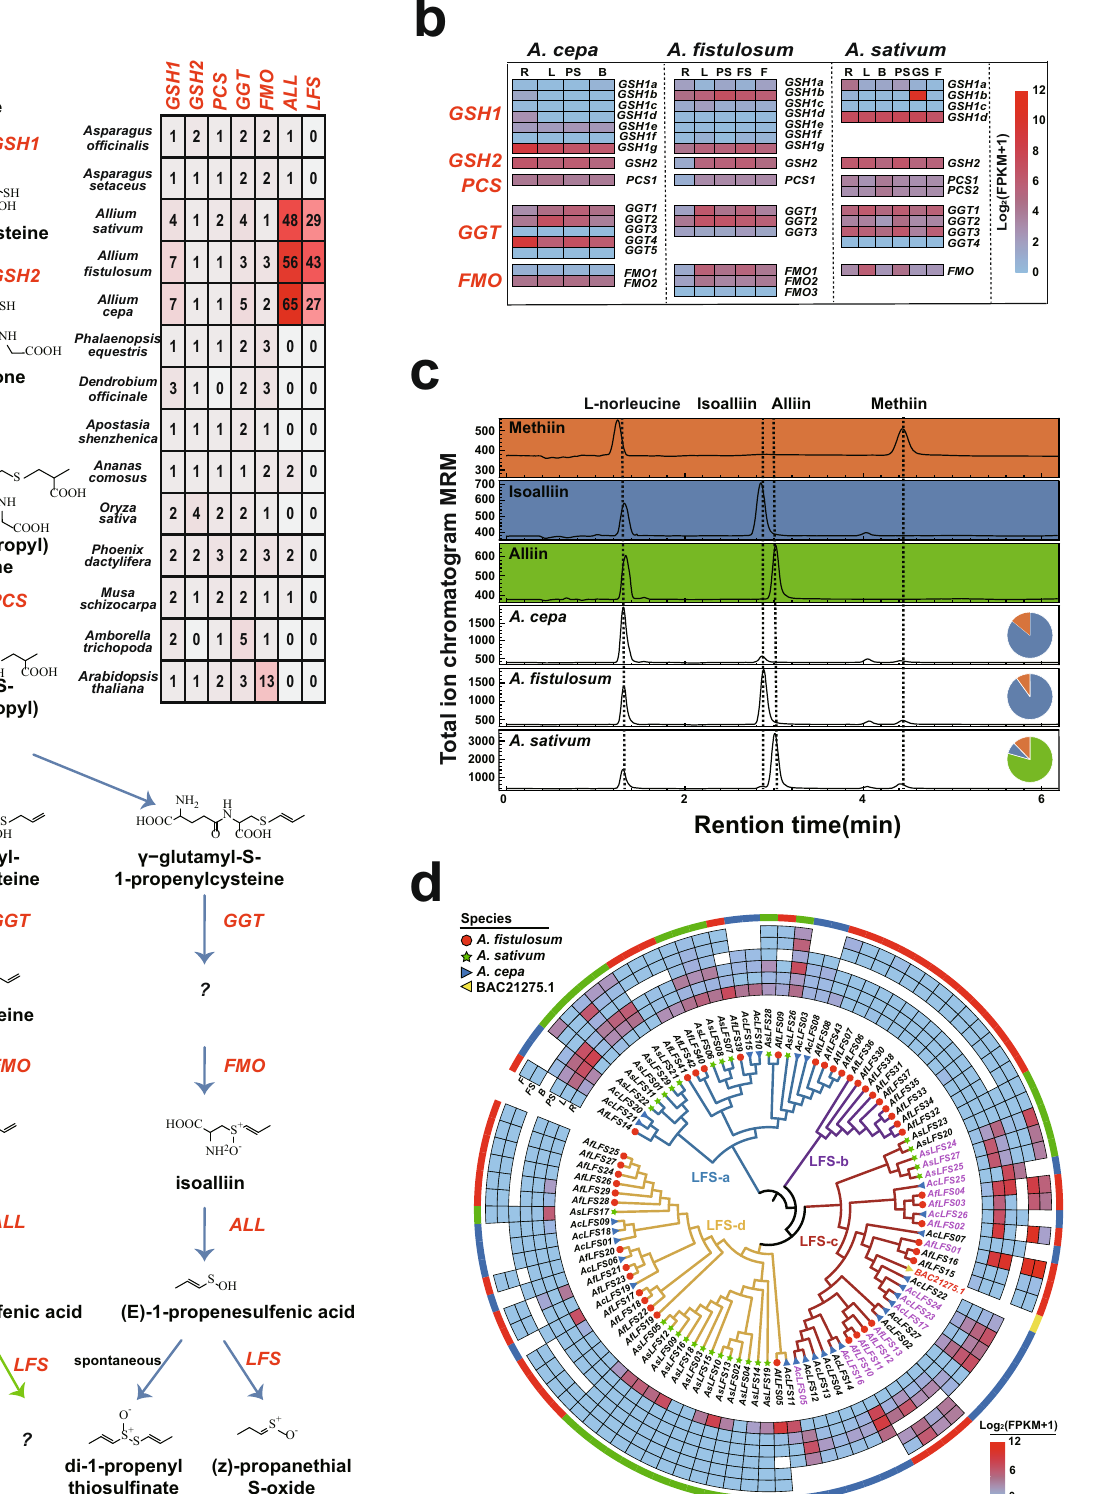
Fig. 4 | Massive duplication and differentiation of sulfur-related genes in Allium . a The biosynthesis and hydrolysis pathway of ACSOs and the number of each fl avor- related gene in the 14 genomes. The pathway in blue relates to the biosynthesis of isoalliin that dominants in bulb onion and bunching onion. The pathway in green relates to the biosynthesis of alliin that dominants in garlic. b Expression patterns of ACSOs biosynthesis genes were investigated in three Allium crops. R roots,Lleaves, PSpseudo-stems, Bbulbs, FS fl oralstalks, F fl owers, GS garlic sprout. The gene details are listed in Supplementary Data 1 – 3.